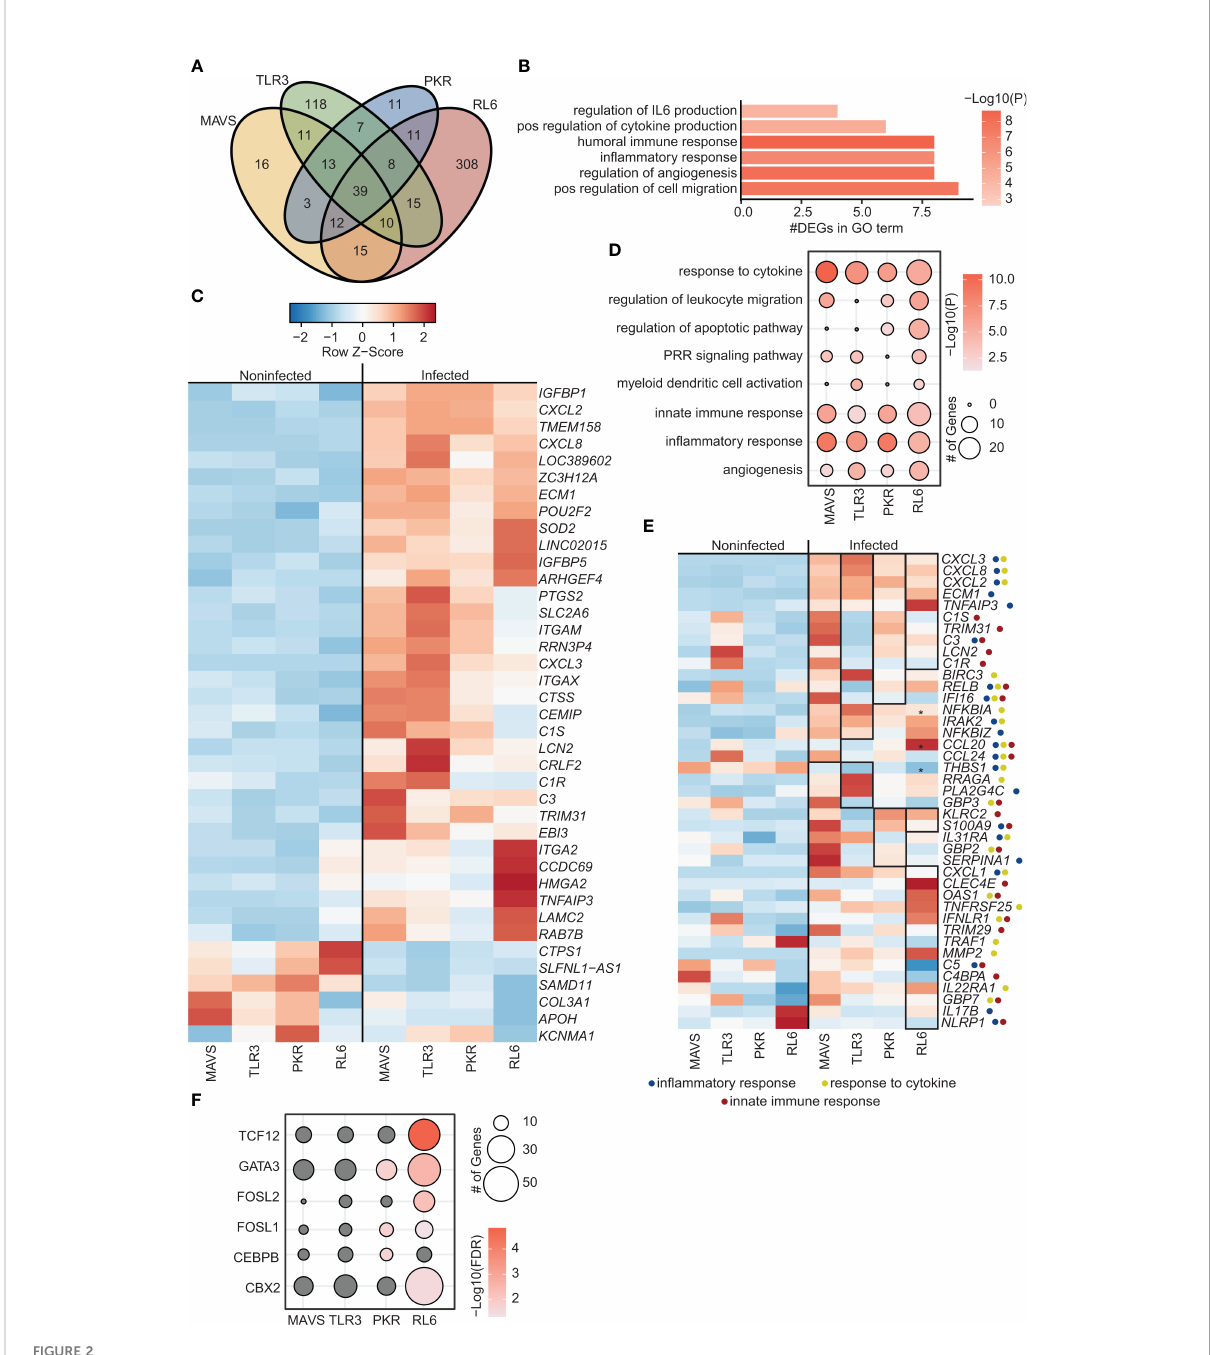
FIGURE 2 Inhibition of Polymerase III in A549 cells lacking antiviral defense genes leads to increased viral replication and altered transcriptomes. (A) Venn diagram of DEGs identi fi ed in siBRF1+ VZV-infected cell lines relative to noninfected counterparts. (B) Bar graph depicting functional enrichment of the 39 DEGs common to all KO cell lines. Horizontal bars represent the number of DEGs enriching to each GO term. Colors are based on the GO terms with the lowest and highest – log(p-value) values. (C) Clustered heatmap comparing TPMs of the 39 DEGs common to all KO cell lines. Color range is based on scaled and centered TPM values. (D) Bubble plot representing functional enrichment of all DEGs in each KO cell line. Size of the bubble indicates the number of DEGs mapping to each GO term. Colors are based on the GO terms with the lowest and highest – log(p-value) values. (E) Clustered heatmap comparing TPMs of all DEGs in each KO cell line. Color range is based on scaled and centered TPM values. Box and * genes are differentially expressed in siBRF1+ infected cell lines relative to noninfected counterparts. Symbol next to gene name represents GO terms the gene maps to. (F) Bubble plot representing transcription factors that are predicted to regulate the DEGs in each KO cell line. The size of the dot represents the number of genes, and the color represents – log(q-value) values. Analysis was performed using the Chea3 web